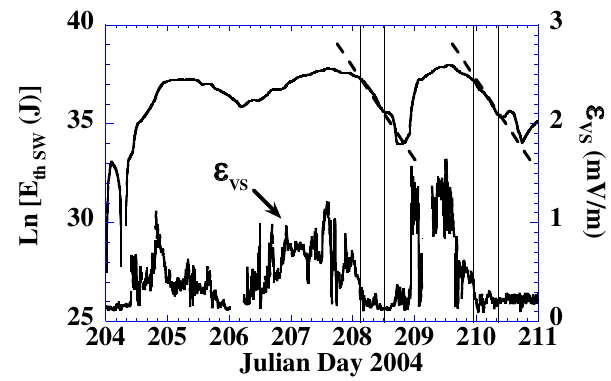
Fig. 6. Natural logarithm of E thSW and ε VS for the disturbances on JDs 206–211, 2004. Vertical lines mark periods of decreased electric fields; slanted lines give the relaxation time τ E